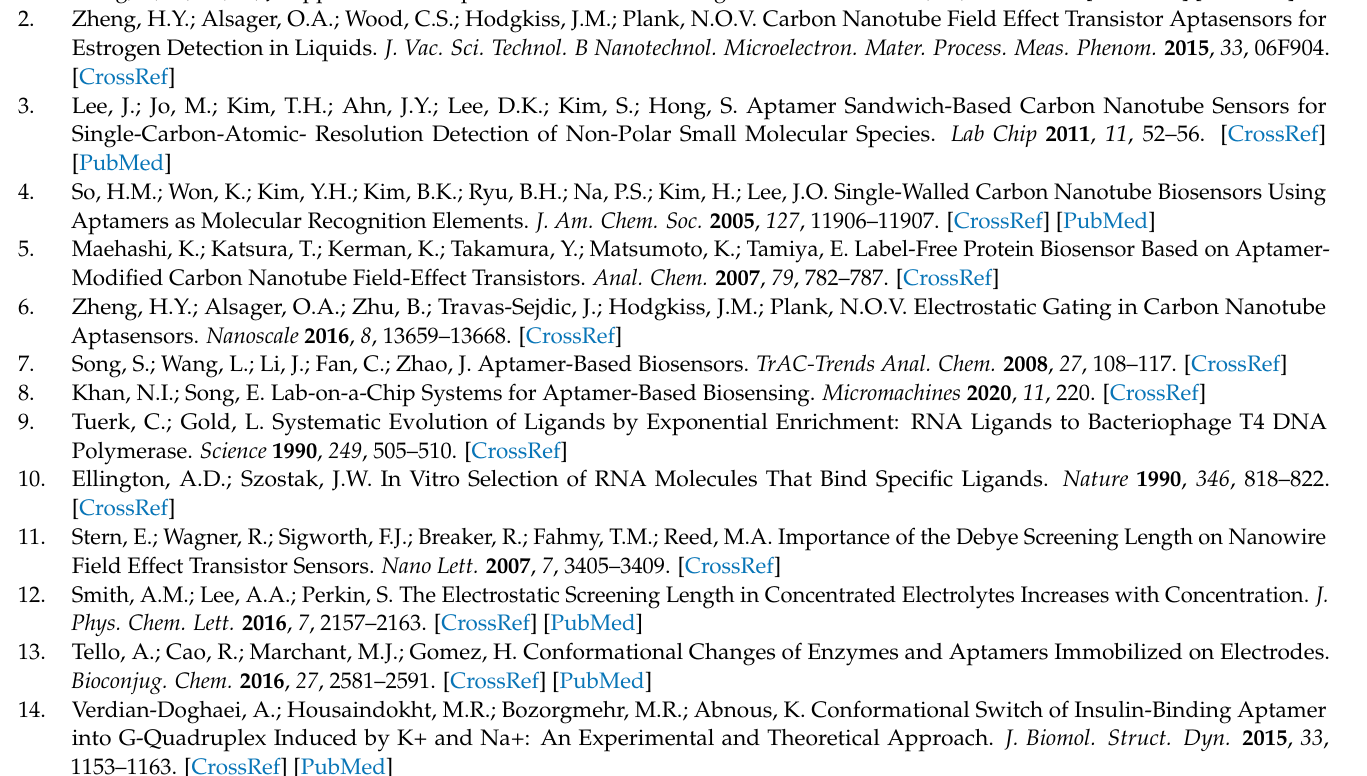
Table S1: Comparison of adenosine detection in various aptasensors